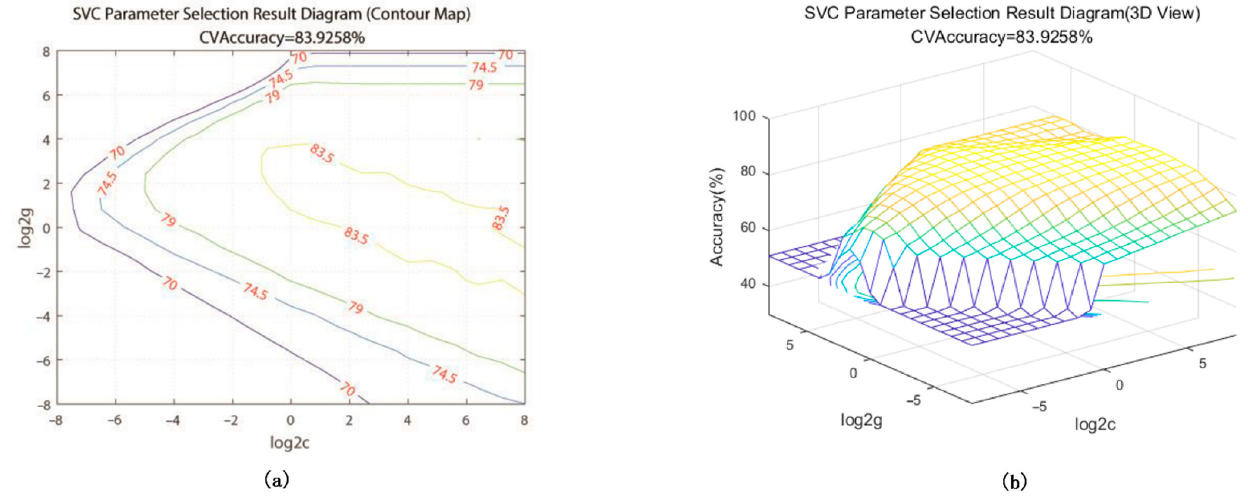
Figure 6. SVC parameter selection result: ( a ) contour map ( b ) 3D view.